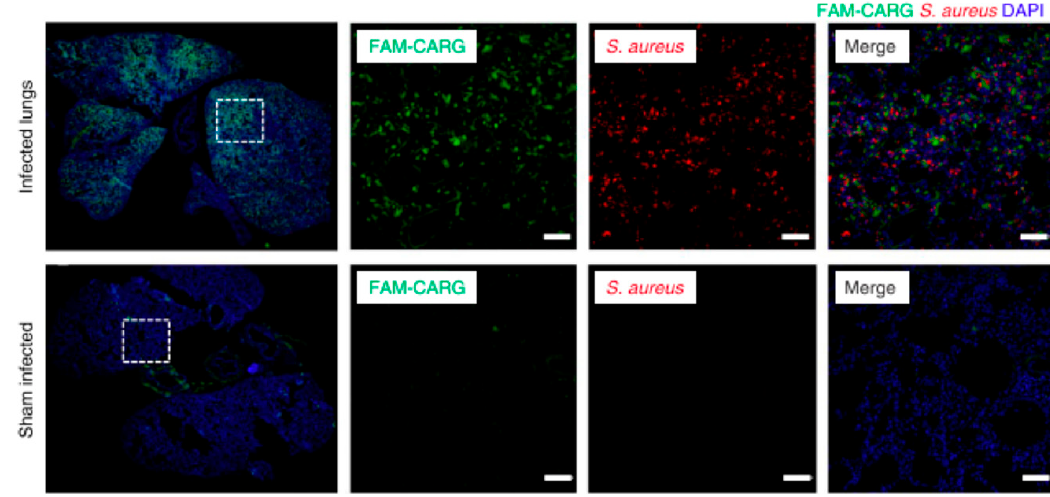
Figure 5. Representative immunofluorescence images of fluorescently labeled peptide CARG (FAM-CARG, green) homing and binding to lungs infected with Staphylococcus aureus ( red; top row ) and sham-infected lungs ( bottom row ) with DAPI ( blue ) staining of nuclei. In each row, the leftmost image shows lung tissue labelled with FAM-CARG ( green ) and DAPI ( blue ); the white box outlines the region of interest (ROI) examined at higher magnification (scale bar = 50um). In each row, the ROI is shown with individual fluorescent channels FAM-CARG ( middle left ) and S. aureus ( middle right ), and all fluorescent channels ( right ). FAM-CARG was intravenously injected into tails of infected mice and allowed to circulate for 30 min prior to sacrifice and histological examination ( n = 3–5 mice per group with 5 histological samples examined per lung). Images modified from [43] and used with permission from Nature Biomedical Engineering.